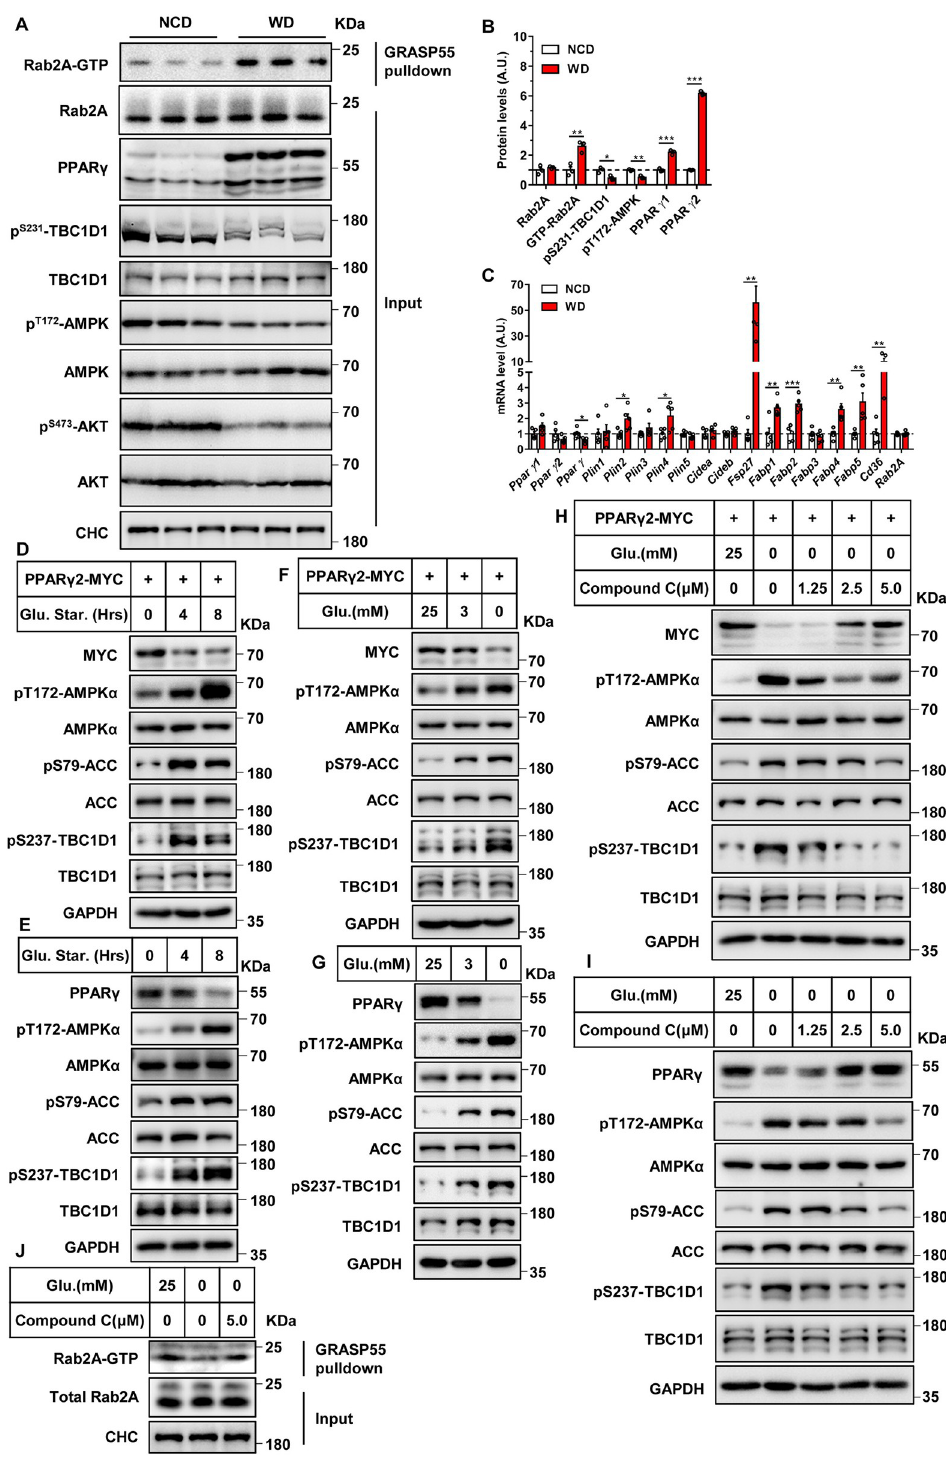
Fig 5. Nutrition levels regulate the activity of AMPK-TBC1D1- Rab2A axis and the subsequent the protein level of PPAR γ . (A) Q-PCR analysis of liver samples. Male mice were fed western diet for 3 months, and liver samples were then collected and analyzed by Q-PCR (random feed, n = 5 per group). (B) Immunoblot analysis of liver samples. Male mice were fed western diet for 3 months, and the liver samples were collected and analyzed by immunoblotting (random feed, n = 3 per group). (C) Quantification of the protein levels shown in B. The data were analyzed